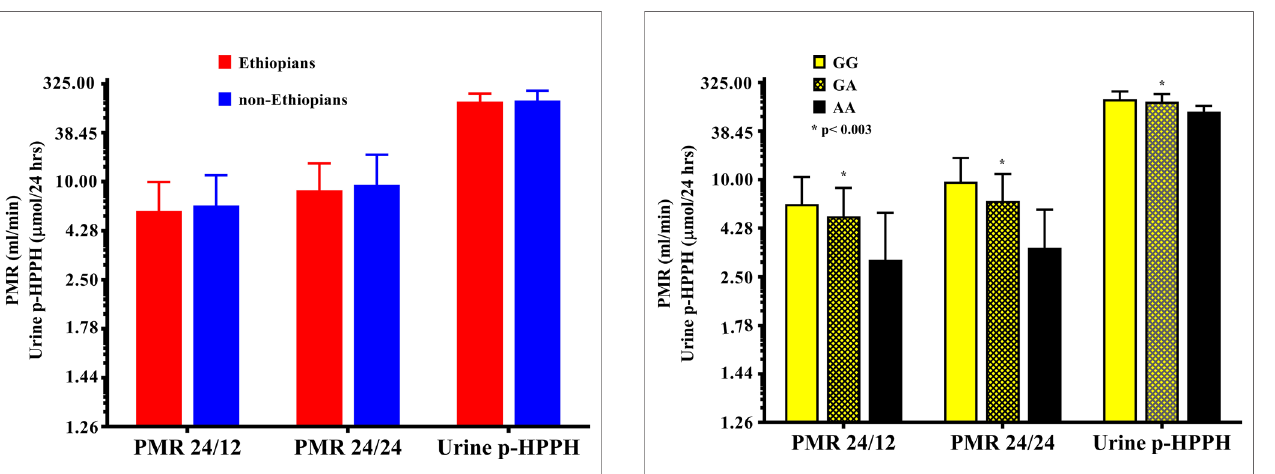
FIGURE 1 | The molar amount of p-HPPH in 24 urine collection, PMR24/12 and PMR24/24 in Ethiopian (red bars) and non-Ethiopian (blue bars) Jews. Log 10 transformed data was used for comparison with anti log 10 values presented on the y-axis. (Statistical comparison between Ethiopian and non-Ethiopian groups was performed by t -test on log 10 transformed data).